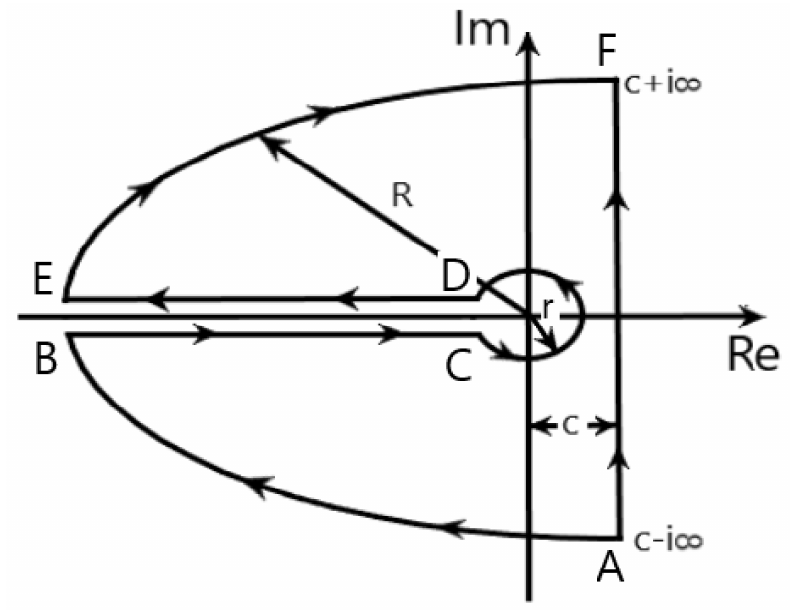
Figure 1. The contour used to invert the Laplace transform given in Equation (23), see Reference [55] for more details.